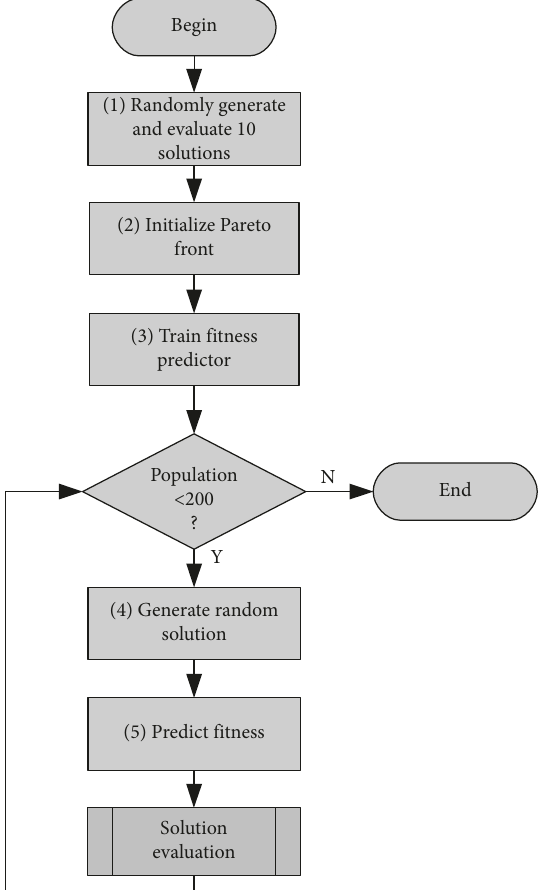
Figure 5: Initial population generation.